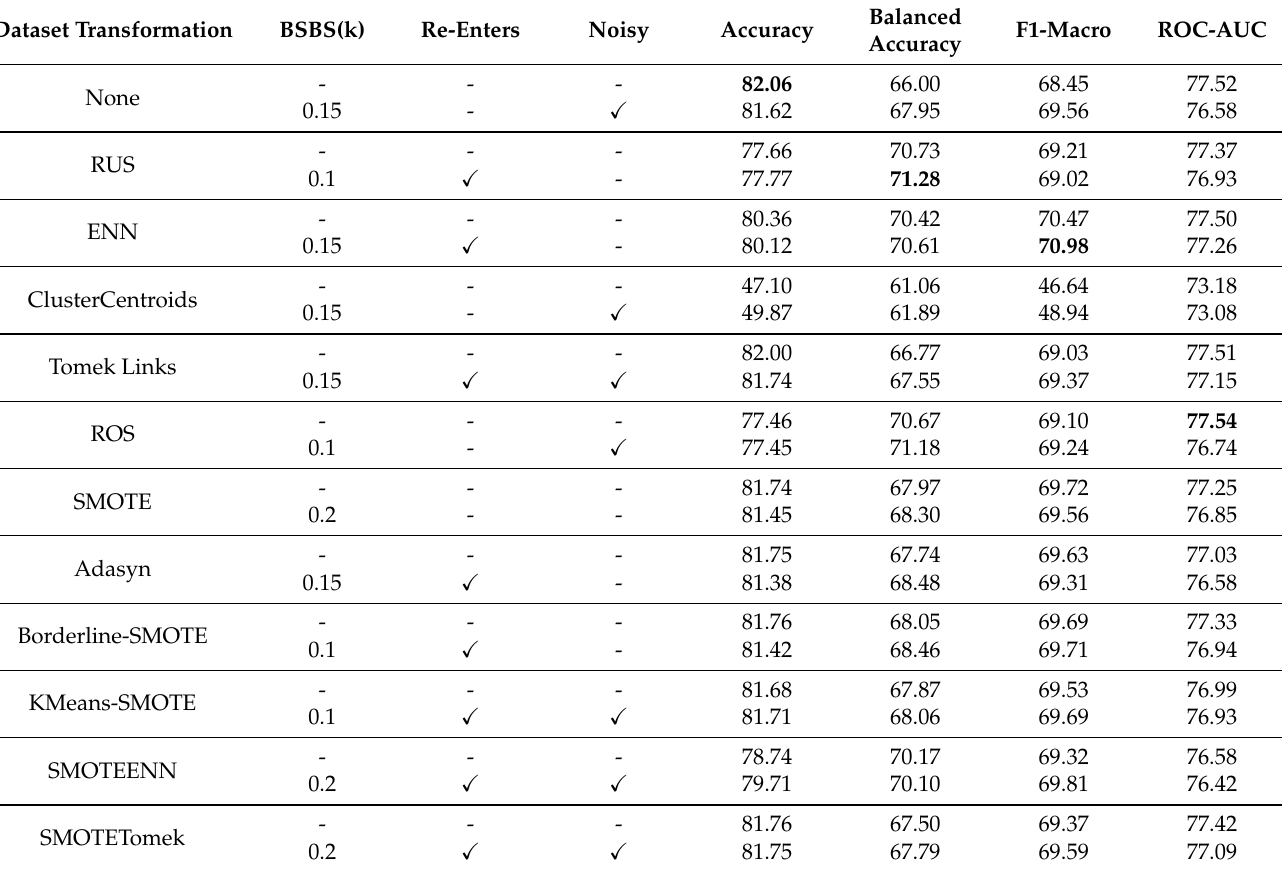
Table 6. Results for the default of creditcard clients dataset.